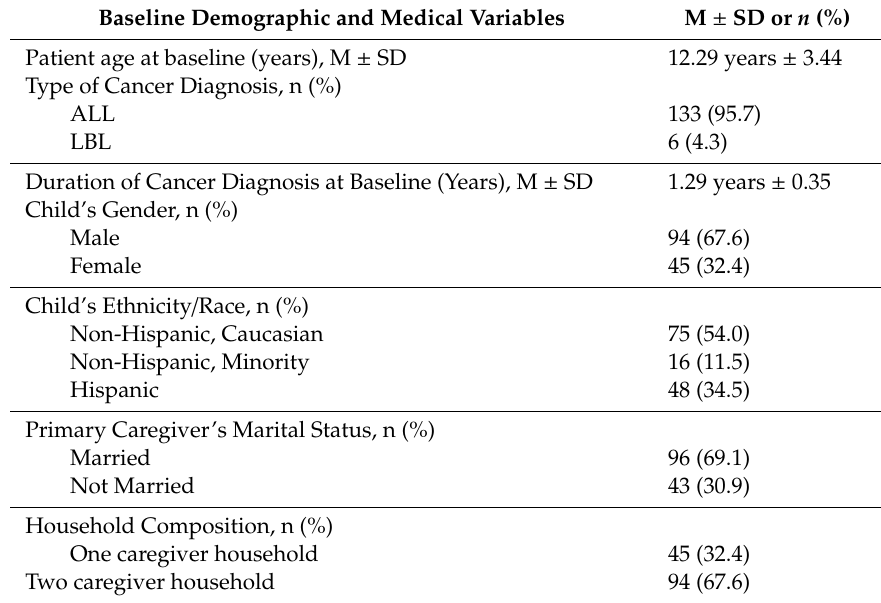
Table 1. Demographic and Medical Characteristics of Baseline Sample ( N =